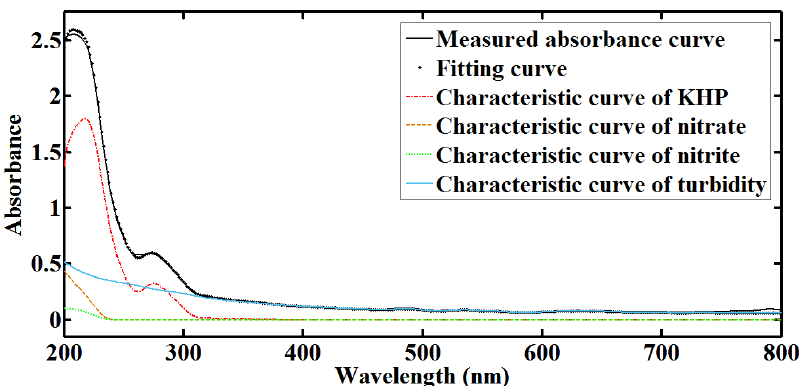
Figure 8. The fitting curve of measured absorbance curve in multi-parameter quantification. Table 1. Comparison of multi-parameter quantification with Dual-PSO and LSSVM. Sample No.